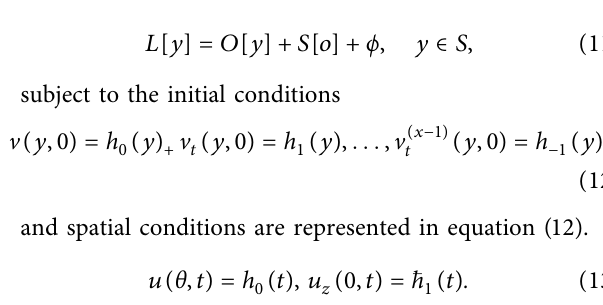
Figure 13: Region of interest separated from segmentation using K -means segmentation. (a) Input image of rice blast. (b) Size adjustment of the input image. (c) Removing the noised image. (d) Diseased part segmented using K -means